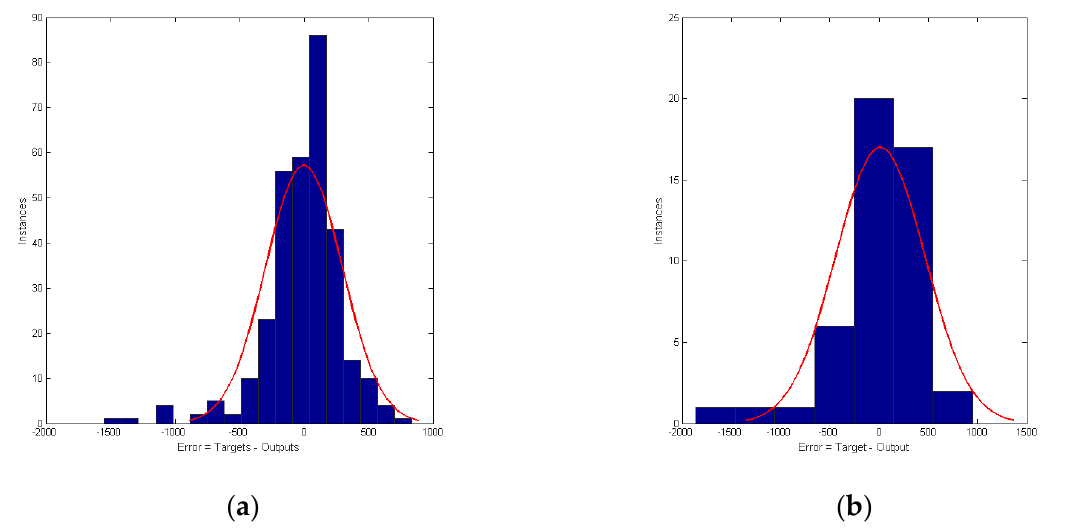
Figure 7. ( a ) Household No 71—Working days forecast error distribution; ( b ) household No 71— Weekend forecast error distribution.